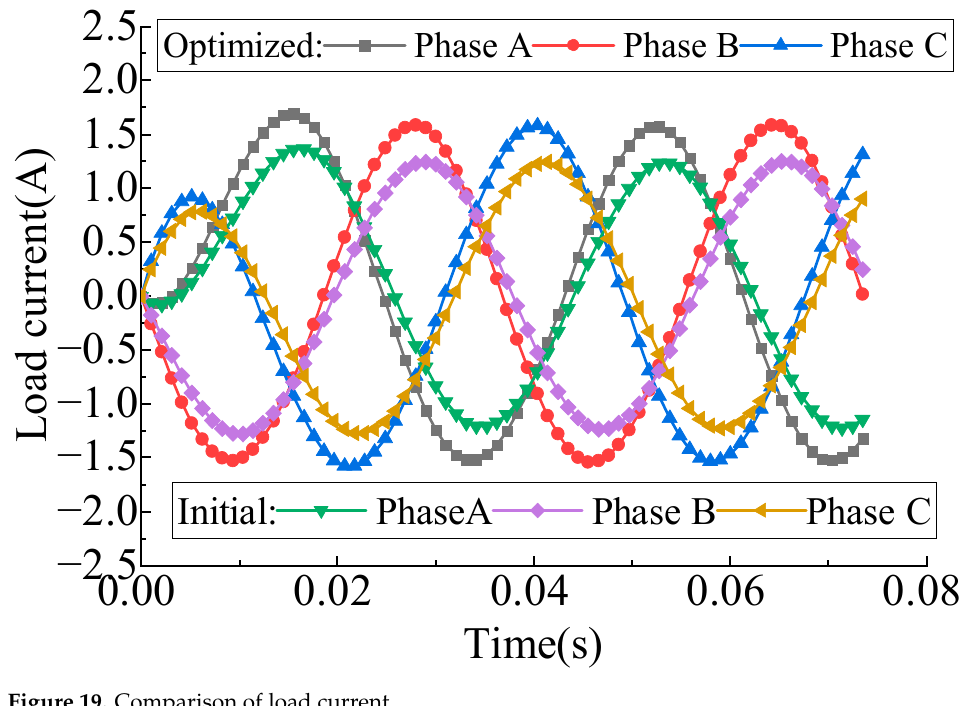
Figure 19. Comparison of load current.